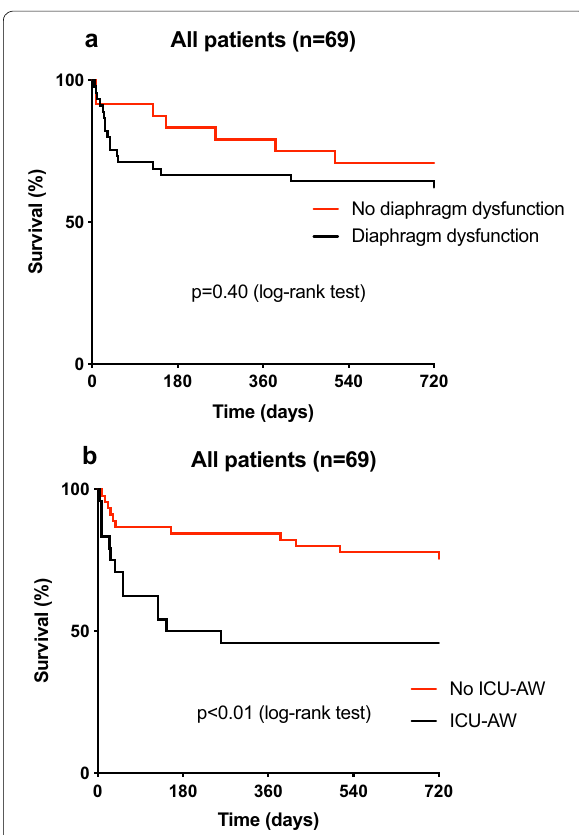
Fig. 2 Kaplan–Meier 2‑year survival curves in patients with and without diaphragm dysfunction ( a ) and in patients with and without ICU‑AW ( b )